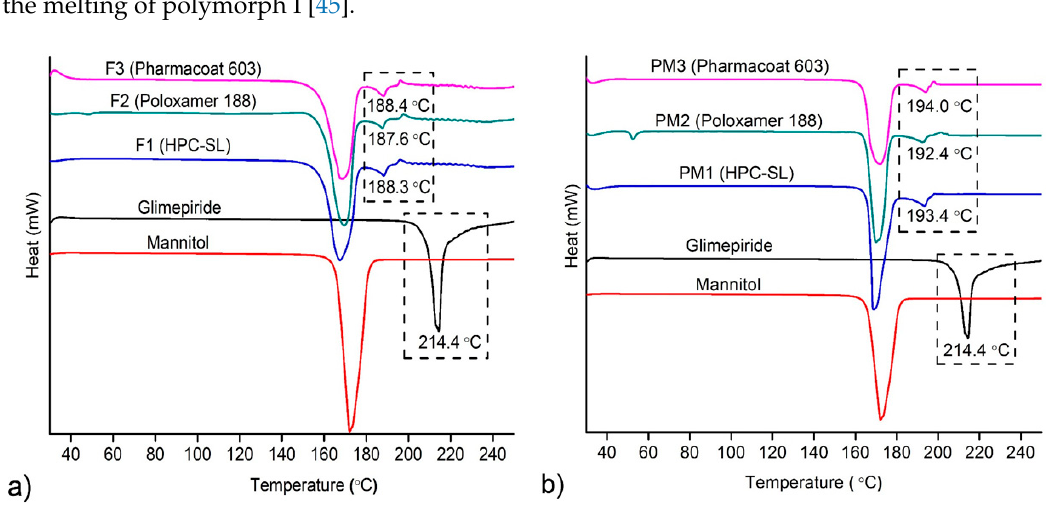
Figure 4. Differential scanning calorimetry (DSC) thermograms of: raw materials ( a ) spray dried nanosuspensions (F1–F3) and ( b ) corresponding physical mixtures (PM1–PM3).